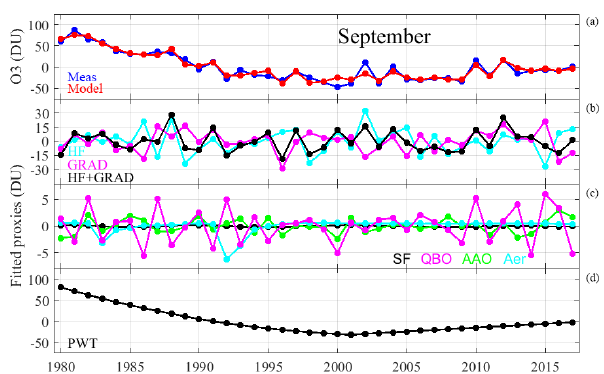
Figure 8. Deseasonalized total ozone inside the vortex of MSR- 2 series (meas) and regression model (model) for September us- ing 400–600K classification (a) . Contributions of proxies are also shown: heat flux (HF), gradient (GRAD) and the combination of both HF and GRAD (b) ; solar flux (SF), QBO (QBO at 30hPa and QBO at 50hPa), Antarctic oscillation (AAO) and aerosol (Aer) (c) ; and PWT (d) . Ozone anomalies and contributions of proxies are given in